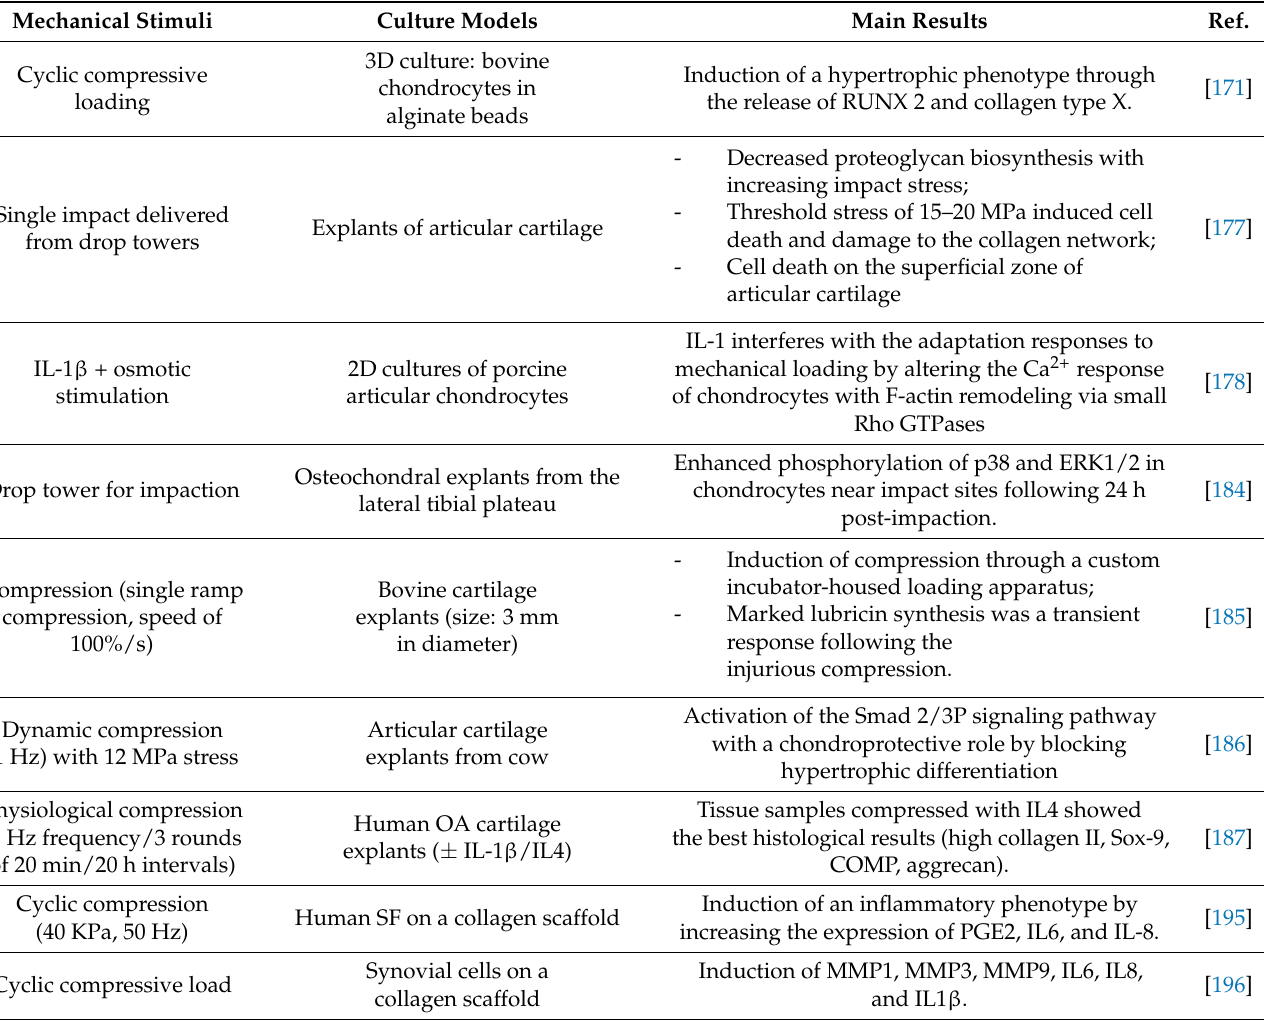
Table 2. List of some biomechanical models in OA with details of the kind of mechanical stimuli, the culture models, the main findings, and the bibliographic